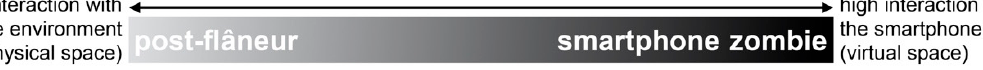
Figure 1. Continuum that shows smartphone users in public space based on the object of their visual attention with post-flâneurs and smartphone zombies at opposite ends (original figure by the authors).